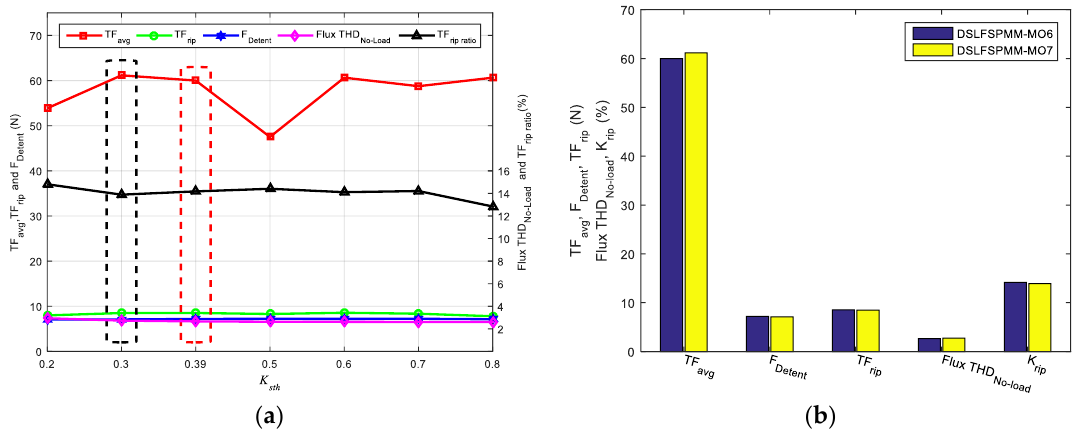
Figure 19. Stator tooth height optimization: ( a ) Performance comparison of DSLFSPMM-MO6 having different 𝐾 𝑠𝑡ℎ values; ( b ) Performance comparison of DSLFSPMM-MO6 and DSLFSPMM-MO7. different K sth values; ( b ) Performance comparison of DSLFSPMM-MO6 and